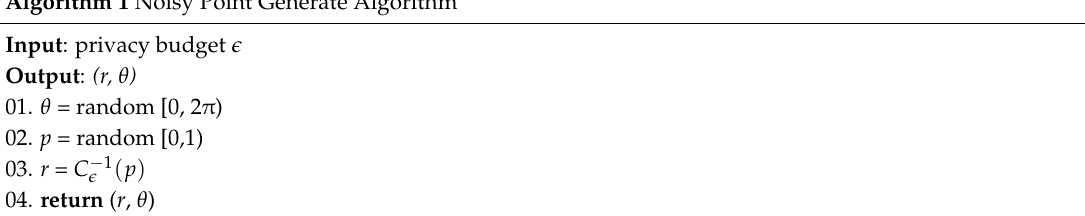
Algorithm 1 Noisy Point Generate Algorithm